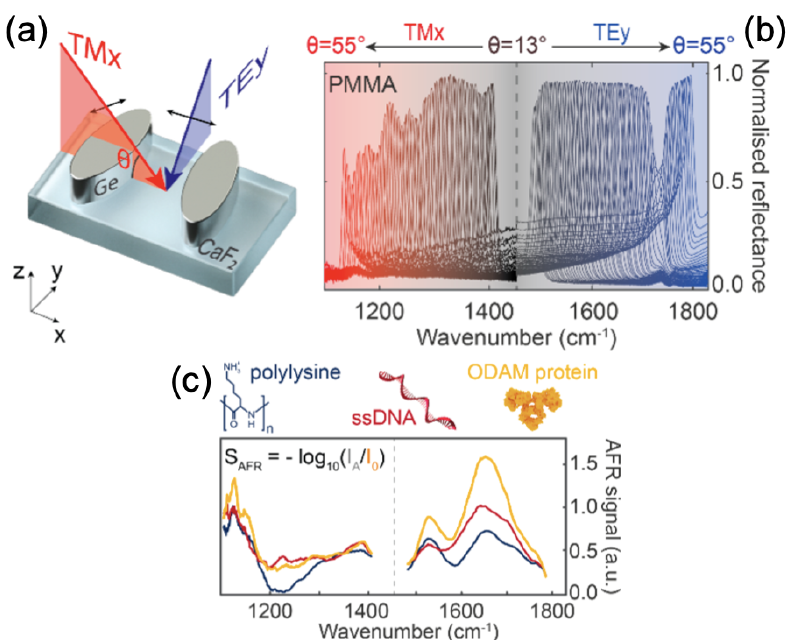
Figure 4. ( a ) Principle scheme of the unit cell for the dielectric metasurface. ( b ) Normalized reflectance spectra for the different incidence angles of light. ( c ) Absorbance spectra of polylysine, ssDNA and ODAM. All the figures are reprinted (adapted) with permission from [80], Copyright 2021 American Chemical Society.